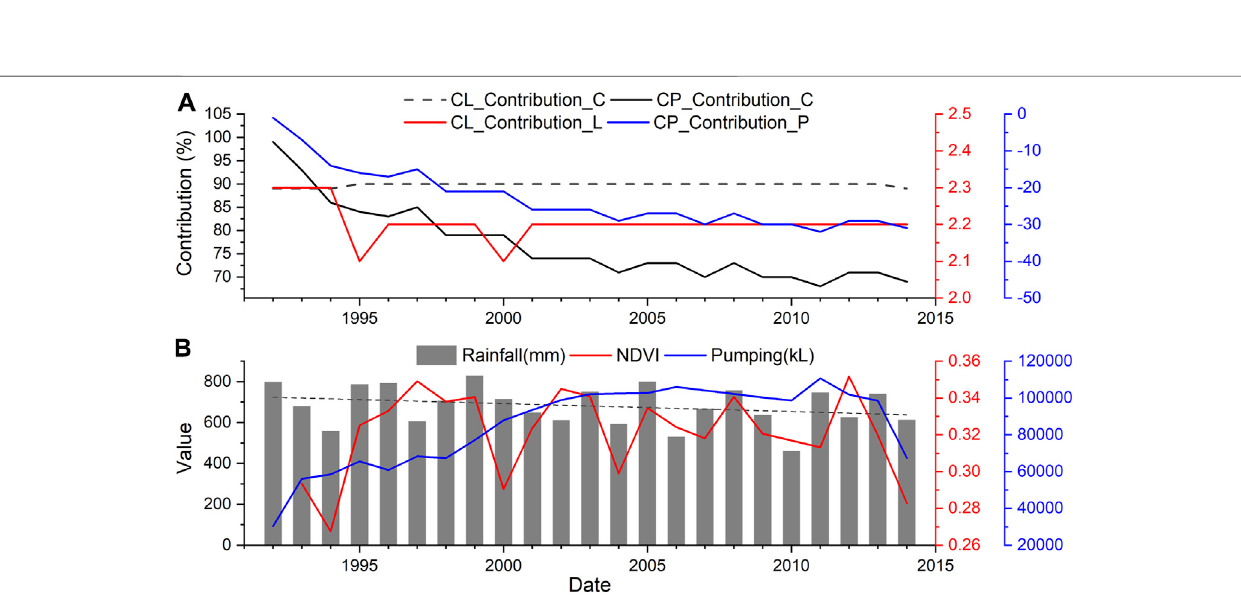
Frontiers in Environmental Science |